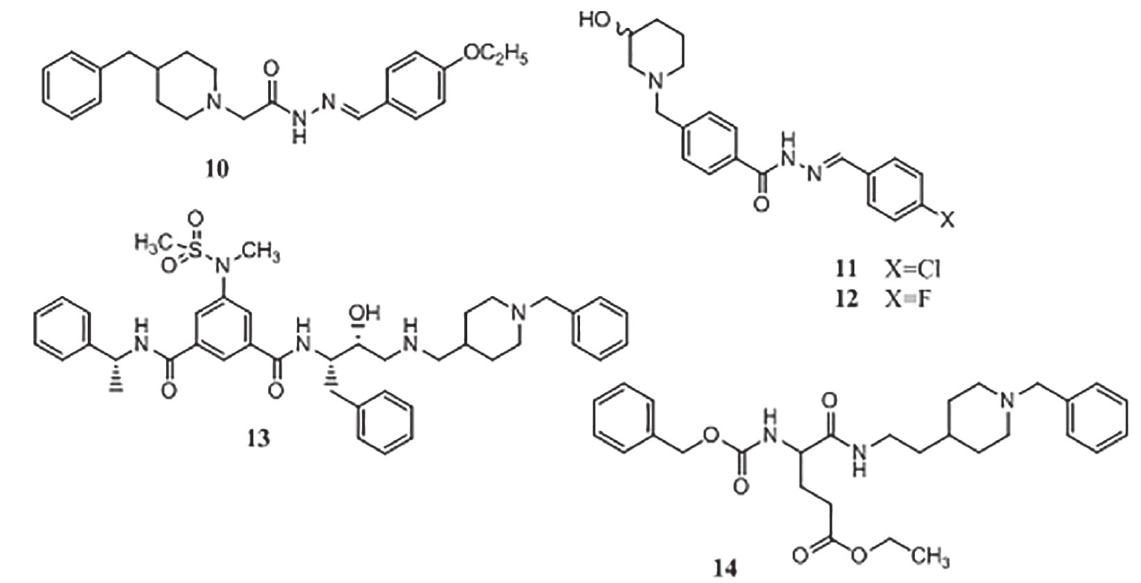
FIGURE 3 - Benzylpiperidine attached with aromatic rings.